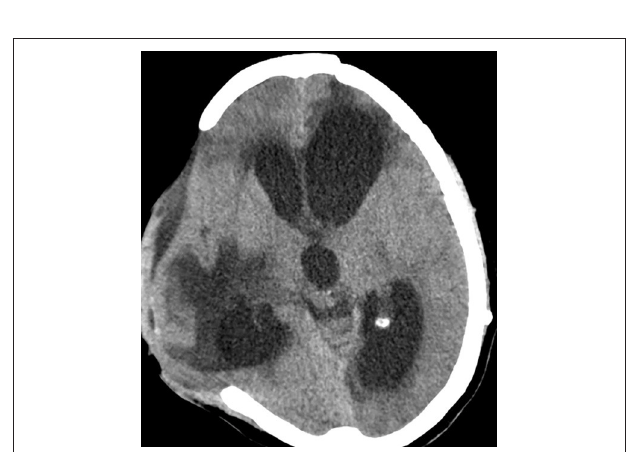
FIGURE 4 | Abdominal wound infection. A partially exposed bone flap is seen through the gaped abdominal storage site, predisposing to infections. FIGURE 5 | Hydrocephalus. Computed tomography depicting a case of hydrocephalus after